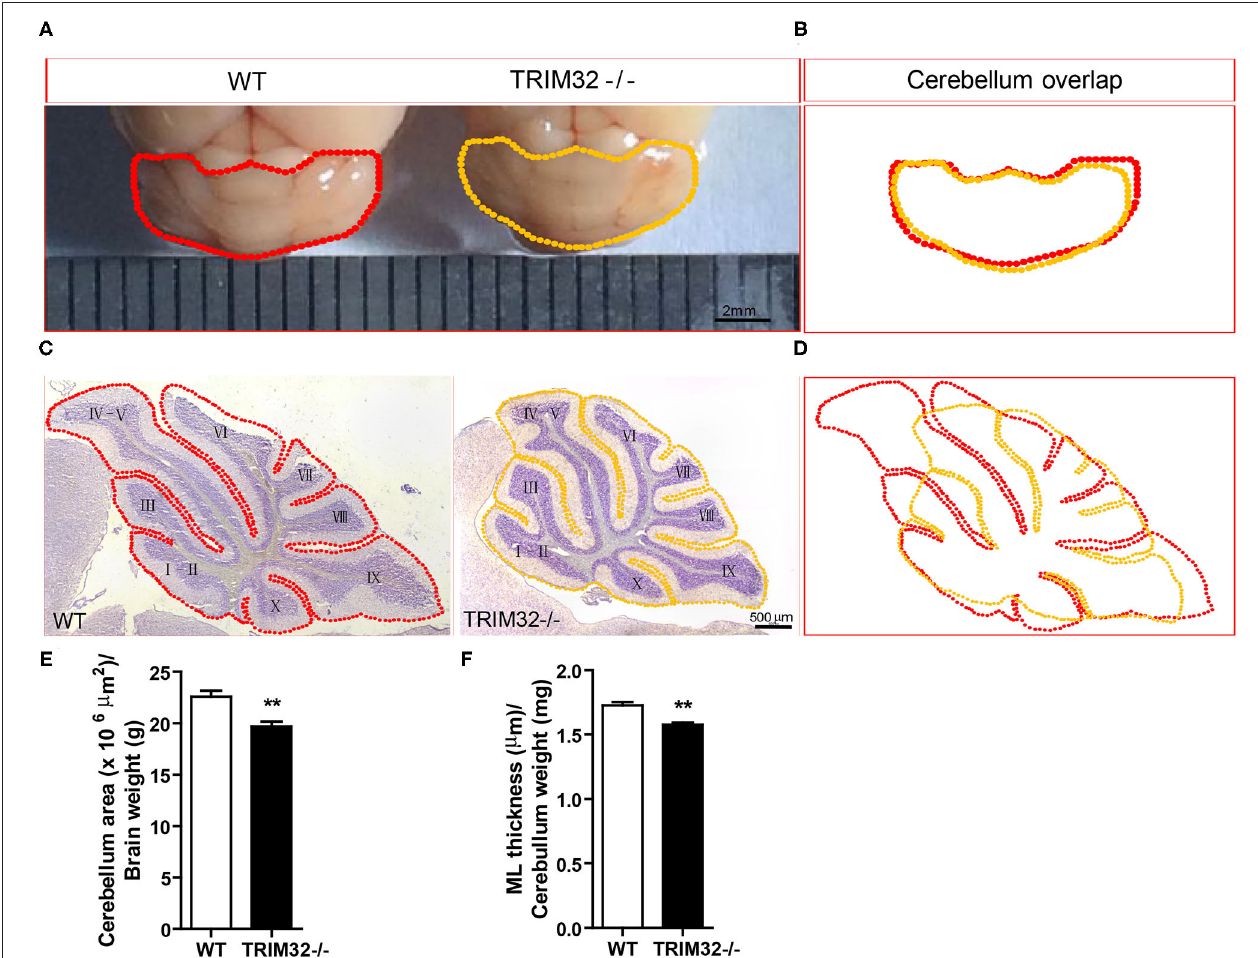
FIGURE 3 | TRIM32 deficiency reduces the size of the mid-aged cerebellum. (A) Macroscopic observation of whole cerebella from mid-aged TRIM32 − / – and WT mice. (B) Reduced size of the mid-aged TRIM32 − / – cerebellum compared with WT in gross morphology. (C) HandE staining sagittal sections of the cerebellum from mid-aged TRIM32 − / – and littermate control mice. (D) A smaller cerebellar area in adult TRIM32 − / – compared with control mice in sagittal sections. (E,F) Histograms representing the quantification of cerebellar area (E) and ML thickness (F) of mid-aged TRIM32 − / – and WT mice. Scale bar = 2mm (A) , 500 µ m (C) . Data were presented as mean ± SEM. n = 5 mice/genotype. ** p <